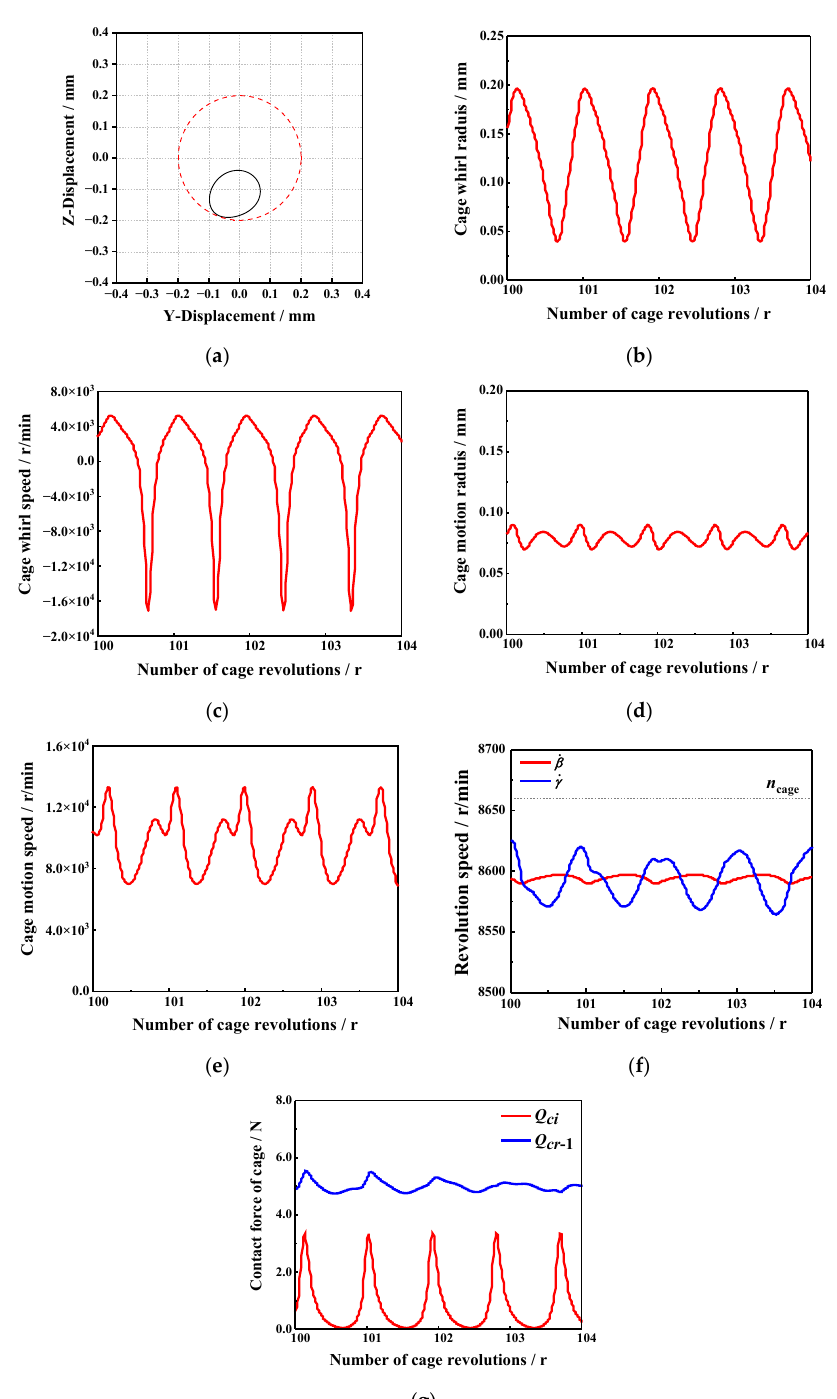
Figure 8. Whirl parameters and force of the cage under operating condition 2: ( a ) whirl orbit; ( b ) whirl radius; ( c ) whirl speed; ( d ) rotational speed of rollers and cage; ( e ) force on cage.